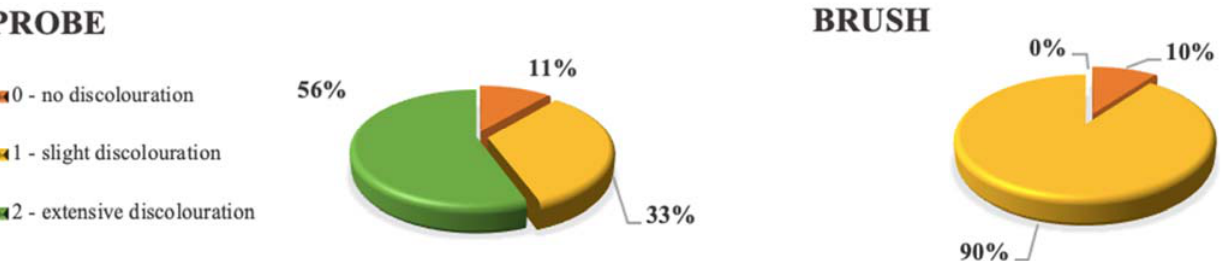
Figure 10. Comparison of discoloration presence between two groups.